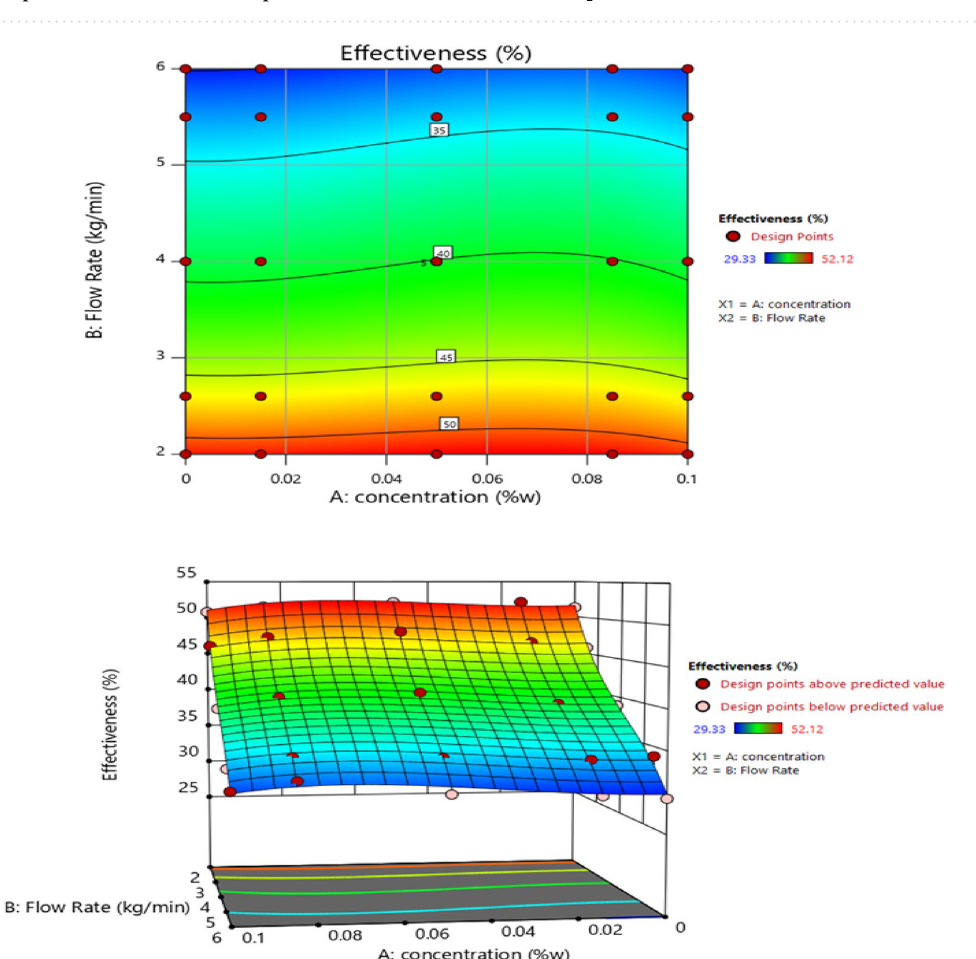
Figure 12. The effect of flow rate and concentration using TiO 2 nanofluid on the effectiveness of CFCT, two- dimensional (contour) and three-dimensional